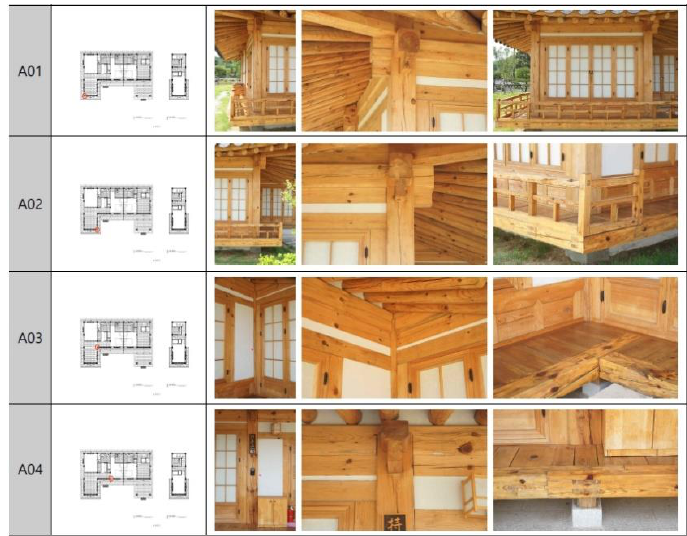
Figure 7. Sample maintenance sheet for the field survey for monitoring Hanok defects.